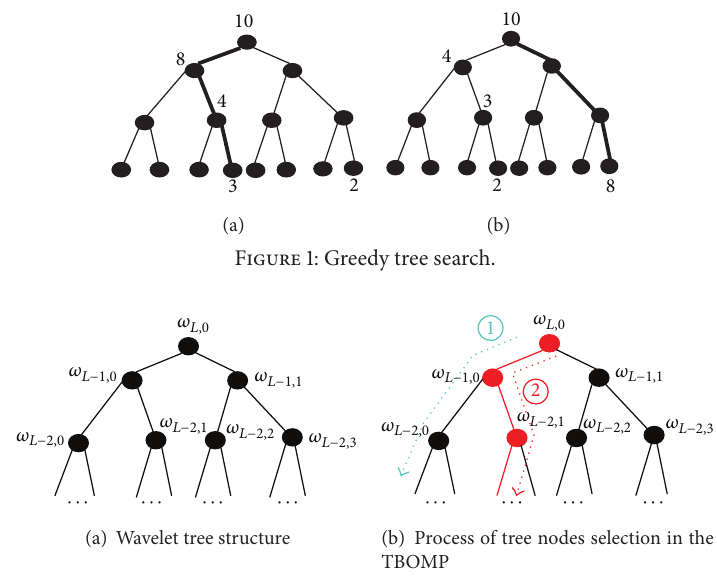
Figure 1: Greedy tree search.